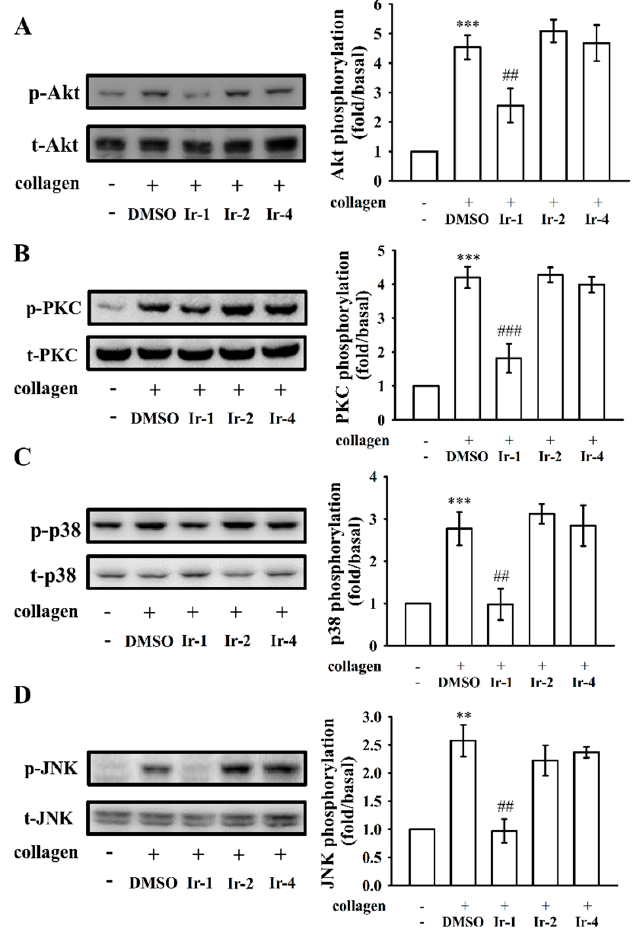
Figure 5. Effects of iridium-III complexes on the phosphorylation of Akt/PKC and MAPKs induced by collagen in human platelets. Washed platelets (1.2 × 10 9 cells/mL) were incubated with solvent control (0.1% DMSO) or 10 μ M Ir-1, Ir-2 and Ir-4 and then treated with 1 μ g/mL collagen to induce